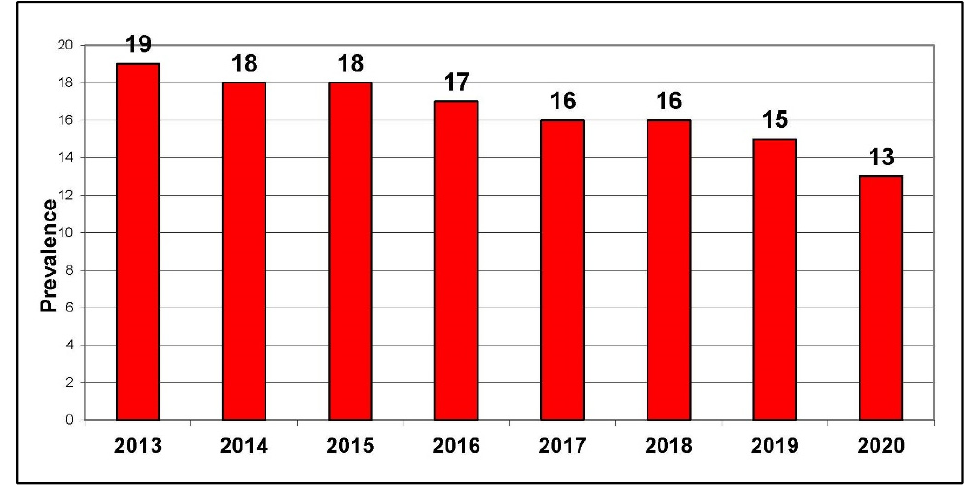
Figure 2. Current smoking prevalence (%) in Canada, age 12+, 2013–2020. Source: Canadian Community Health Survey.